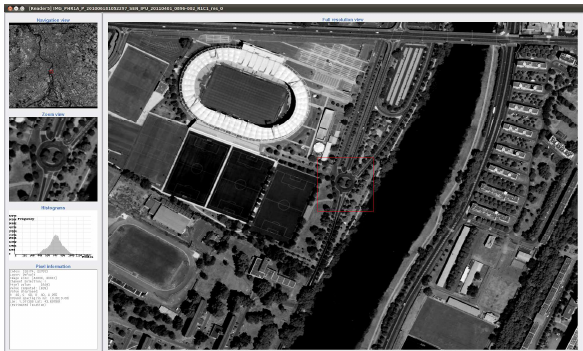
Figure 2. Monteverdi viewer on simulated Pleiades images